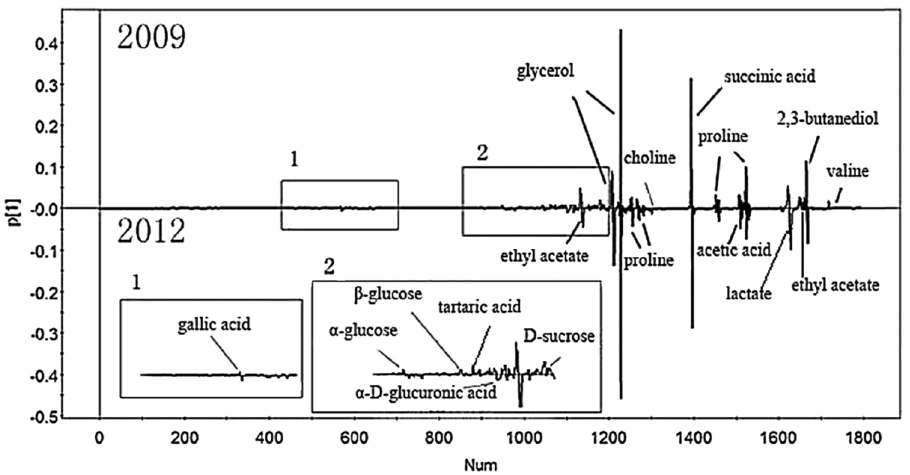
Figure 11: PLS - DA loading plot chart from 1 H NMR spectra of 2009 and 2012 vintage Cabernet Sauvignon wines.